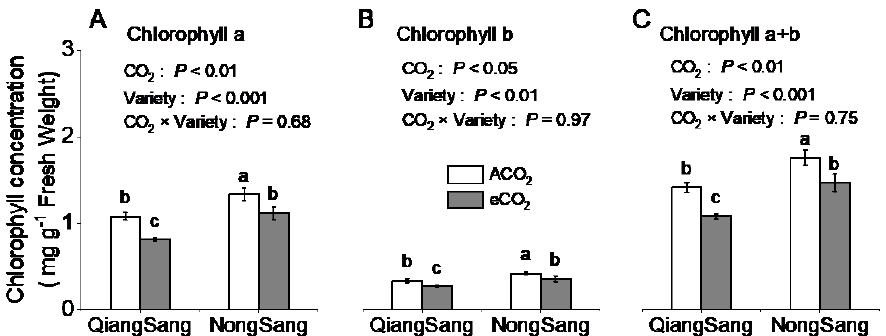
Figure 2. Concentrations of leaf chlorophyll a ( A ), chlorophyll b ( B ) and chlorophyll a+b ( C ) in two mulberry varieties ( Morus multicaulis Perr. var. QiangSang and NongSang) grown under ambient CO 2 (ACO 2 , 410/460 ppm, daytime/nighttime) and elevated CO 2 (eCO 2 , 710/760 ppm) levels. Data (means ± SE, n = 3) followed by different letters indicate significant differences ( p < 0.05) as revealed by Tukey’s test. Statistical comparisons (two-way ANOVA) between varieties and CO 2 treatments as well as their interaction (CO 2 × variety) are presented for each variable.